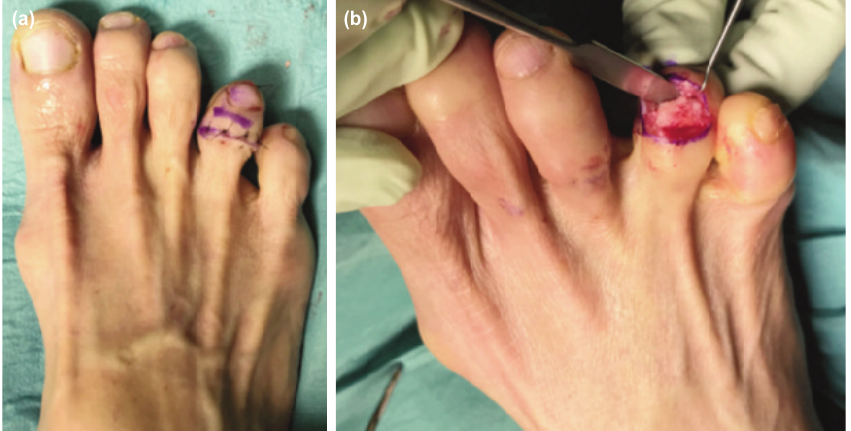
(a) Surgical approach with dorsal transverse incision over right fourth toe distal inter-phalangeal joint. (b) Fibrous tissue at Fig. 2: fracture site with sclerotic bone edges.